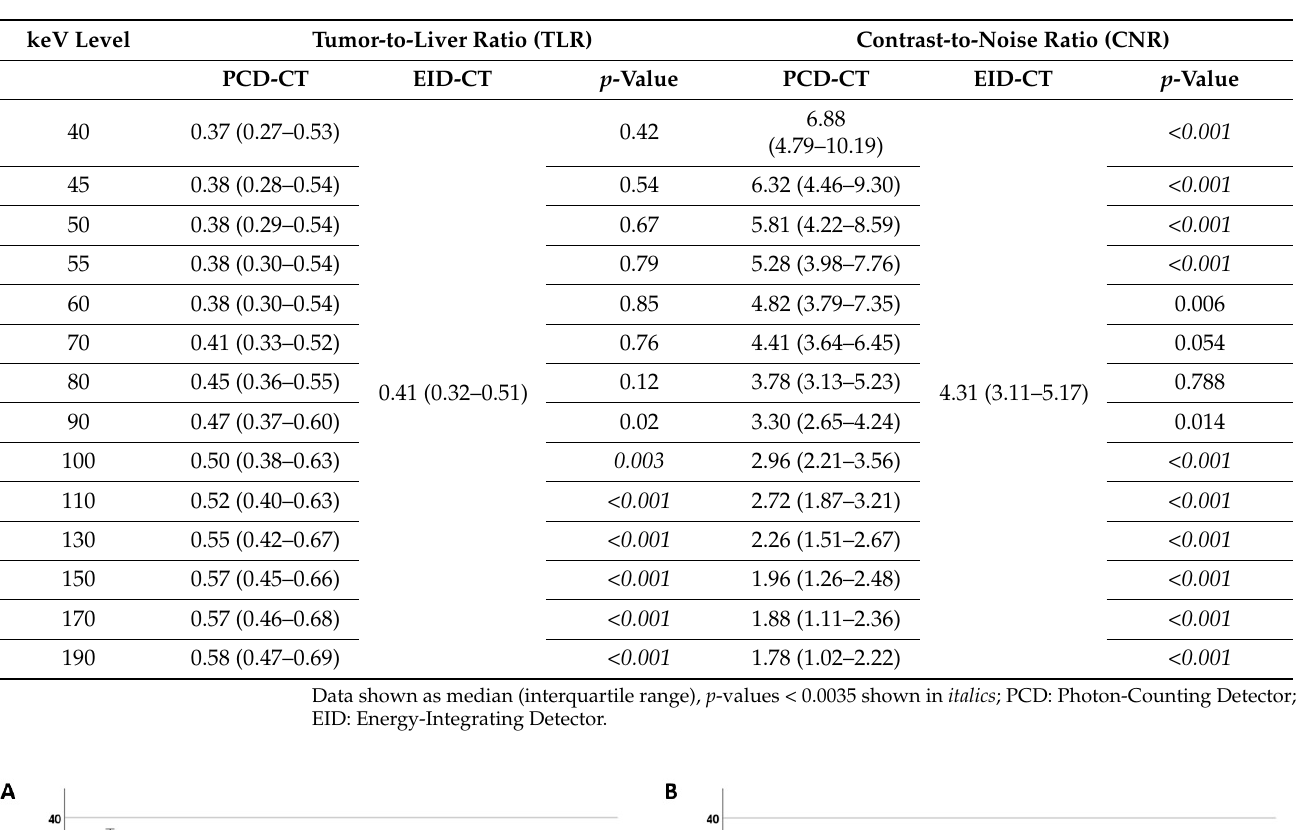
Table 2. Tumor-to-liver ratio and contrast-to-noise ratio at different keV levels.